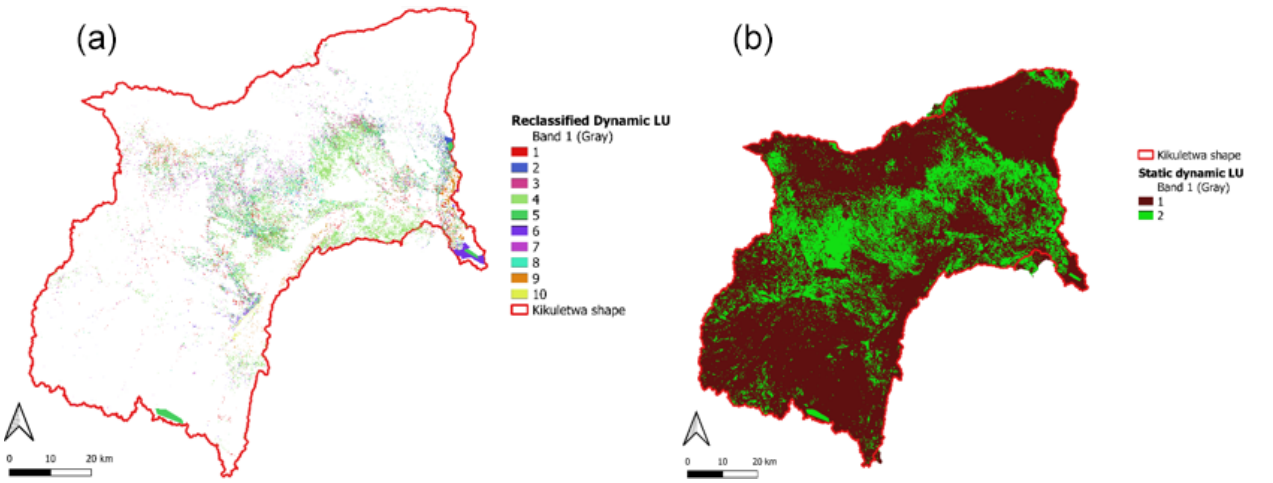
Figure 3. Spatial distribution of main dynamic land use trajectories (a) and the distinction between dynamic and static land use (b) identified in the study